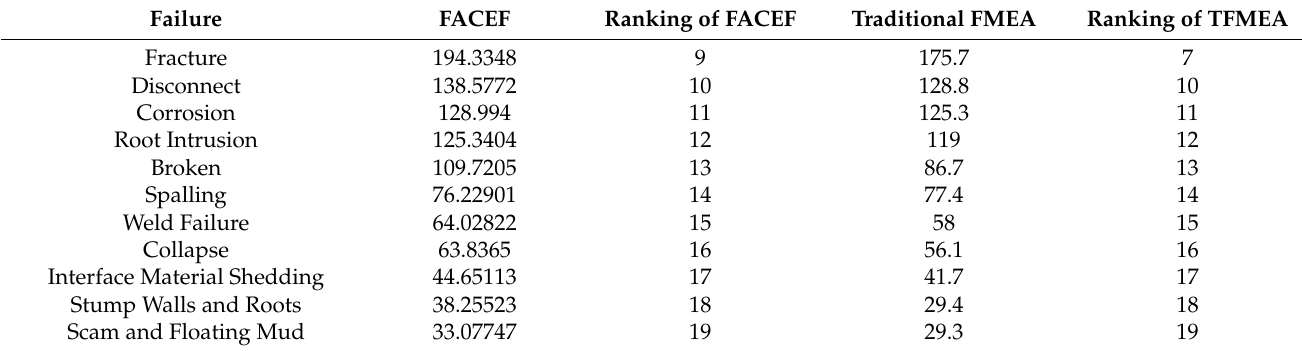
Figure 8. Mean values of 𝑂 . Figure 9. Mean values of 𝐷 .